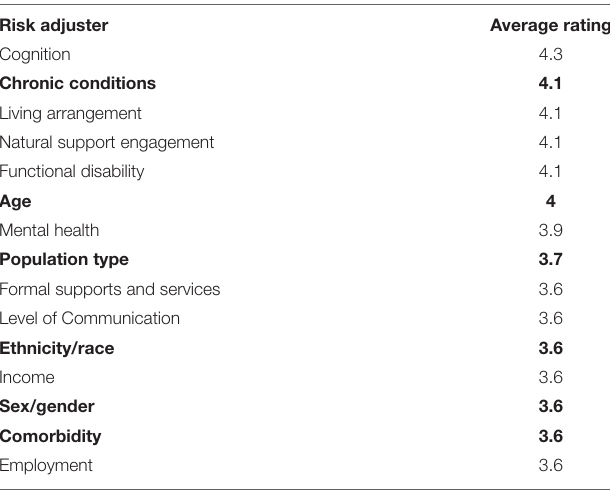
TABLE 4 | Average ratings by expert panel of top half of rated individual level risk